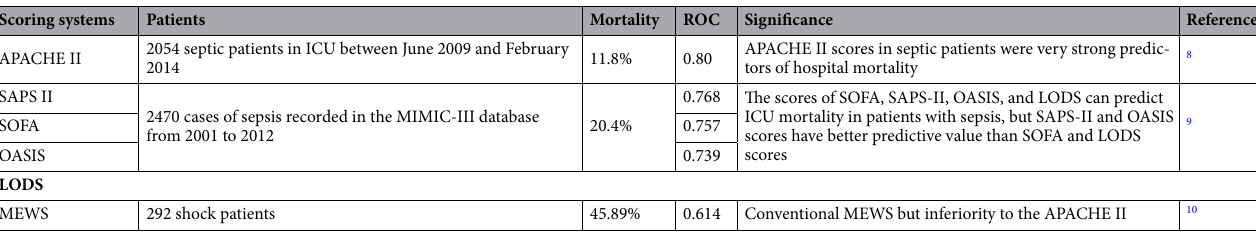
Table 1. Comparison of scoring systems for predicting ICU mortality. APACHE II Acute Physiologic Assessment and Chronic Health Evaluation II, SOFA Sequential Organ Failure Assessment, SAPS-II